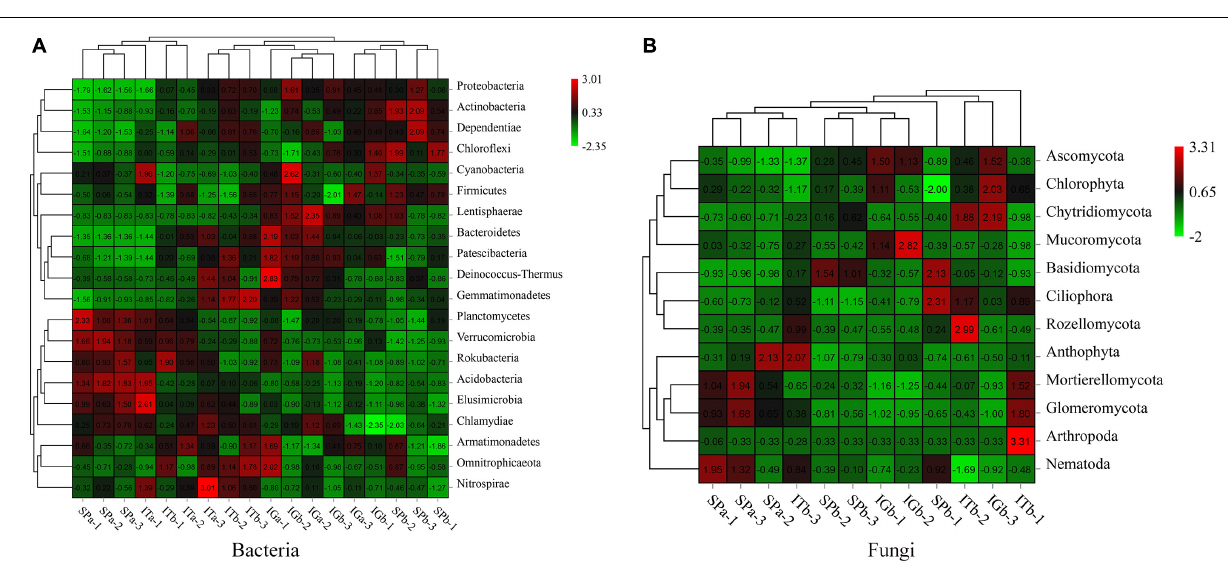
( P < 0.05), which may indicate intercropping with turmeric can improve the metabolic function of soil microbial